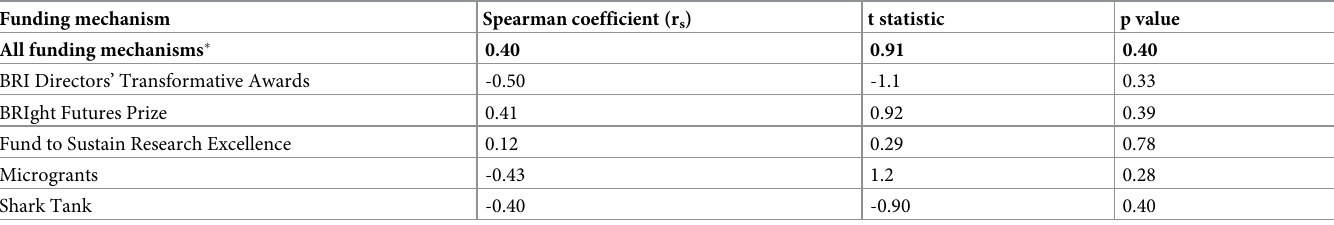
Table 4. Spearman rank-order correlations for BRI funding programs over